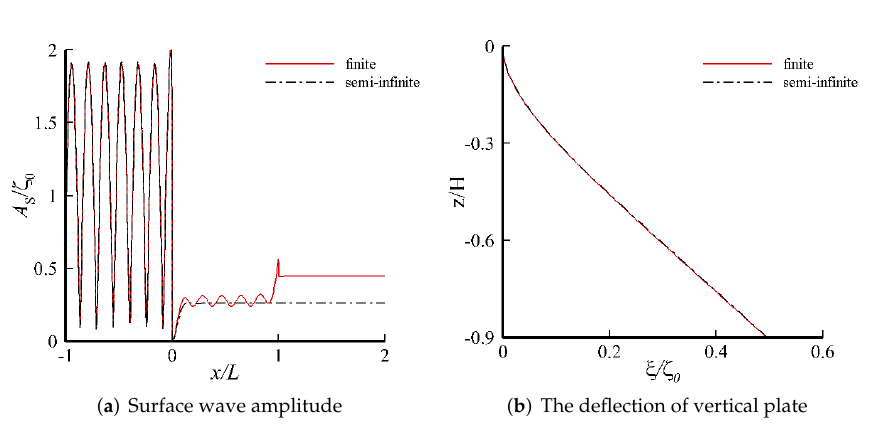
Figure 6. Wave amplitudes A S ( x ) and deflection of vertical plate ξ ( z ) with ω = 1.25.